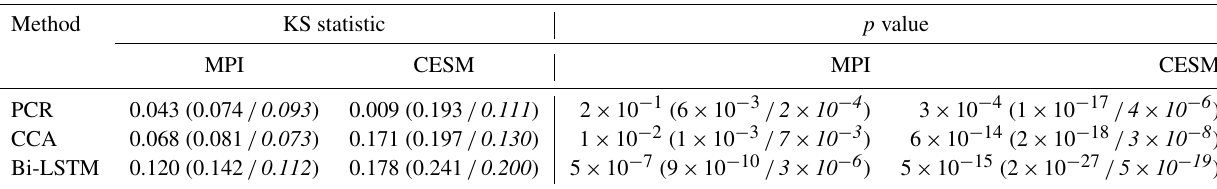
Figure 14. Histogram for the decadal filtered NH mean index. The x axis denotes temperature anomaly values, and the y axis is the number of data points in each bin. A total of 30 bins are selected to plot each of the histograms. Table 4. Kolmogorov–Smirnov test statistic and p value for quantifying the histogram distributions between model and reconstructed NH decadal means. Low values of the KS statistic indicate a larger similarity between the two distributions. The numbers in parentheses indicate the KS statistic and p value of white-noise-contaminated and red-noise-contaminated (italics)